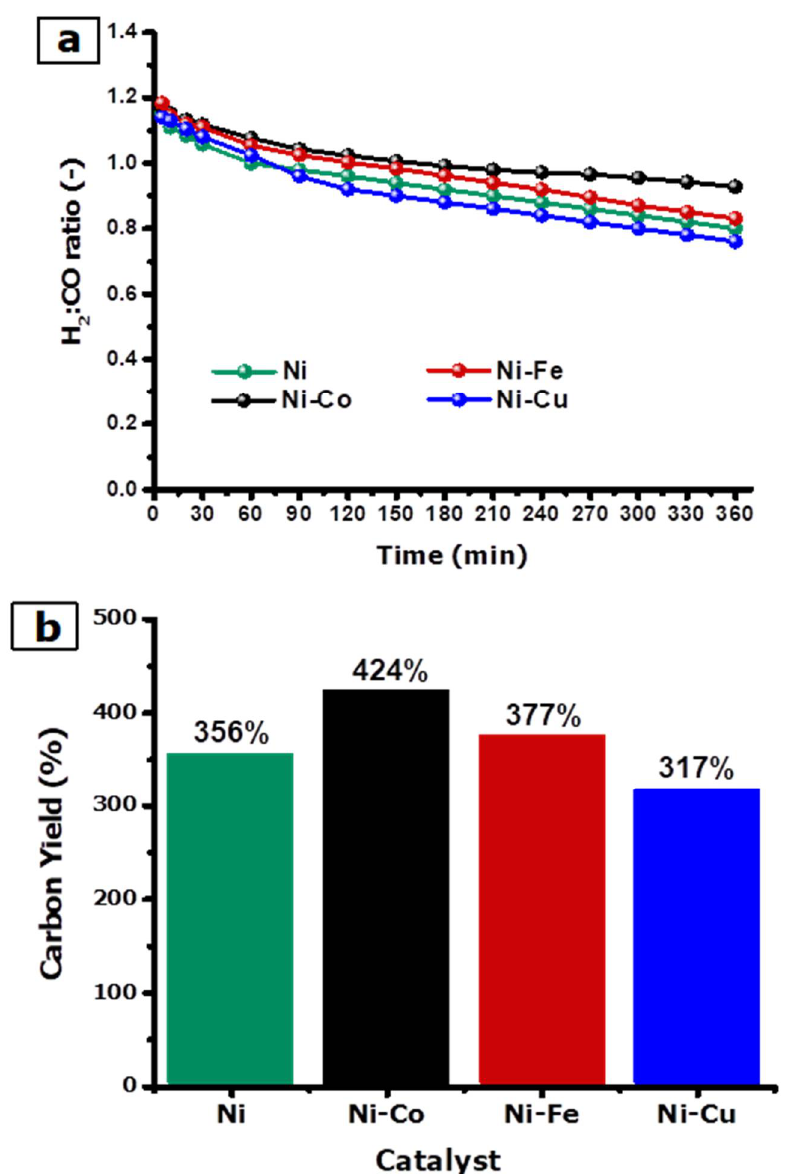
Figure 11. ( a ) H 2 :CO ratio as a function of TOS and ( b ) carbon yield percentage ( Y C ) for Ni, Ni-Co, Ni-Fe, and Ni-Cu at 700 °C and 100 mL min −1 .